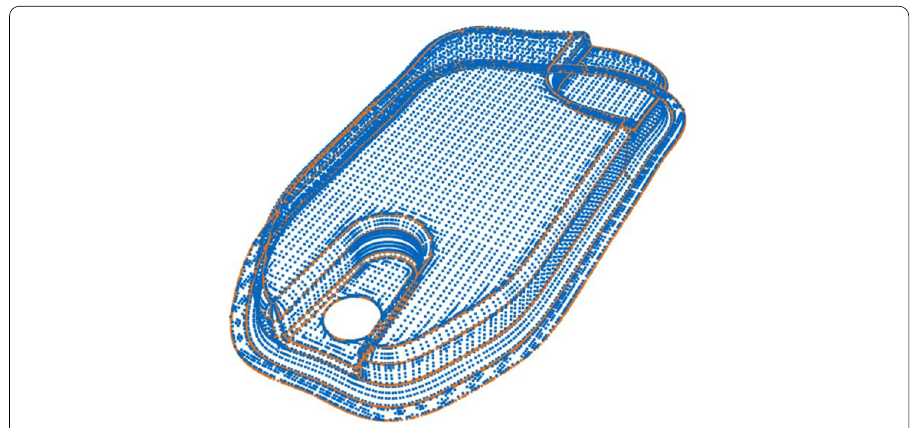
Fig. 12 Integrationdomain of the oilsump from Fig. 11. Blue points are surface integration points. Orange points are boundary edge integration points